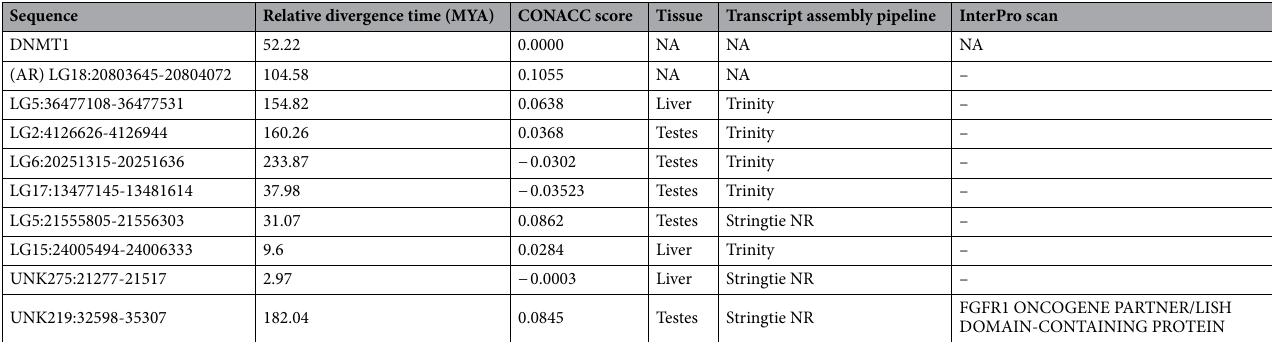
Table 3. The relative divergence time between O. niloticus and P. nyererei , along with the deviation from the Neutral Model that was calculated using CONACC Scores, which tissues these nORF’s where found in, what pipeline was used to assemble the transcripts and whether these nORFs shared any domains with known proteins. These nORFs were identified in the intergenic region of O.